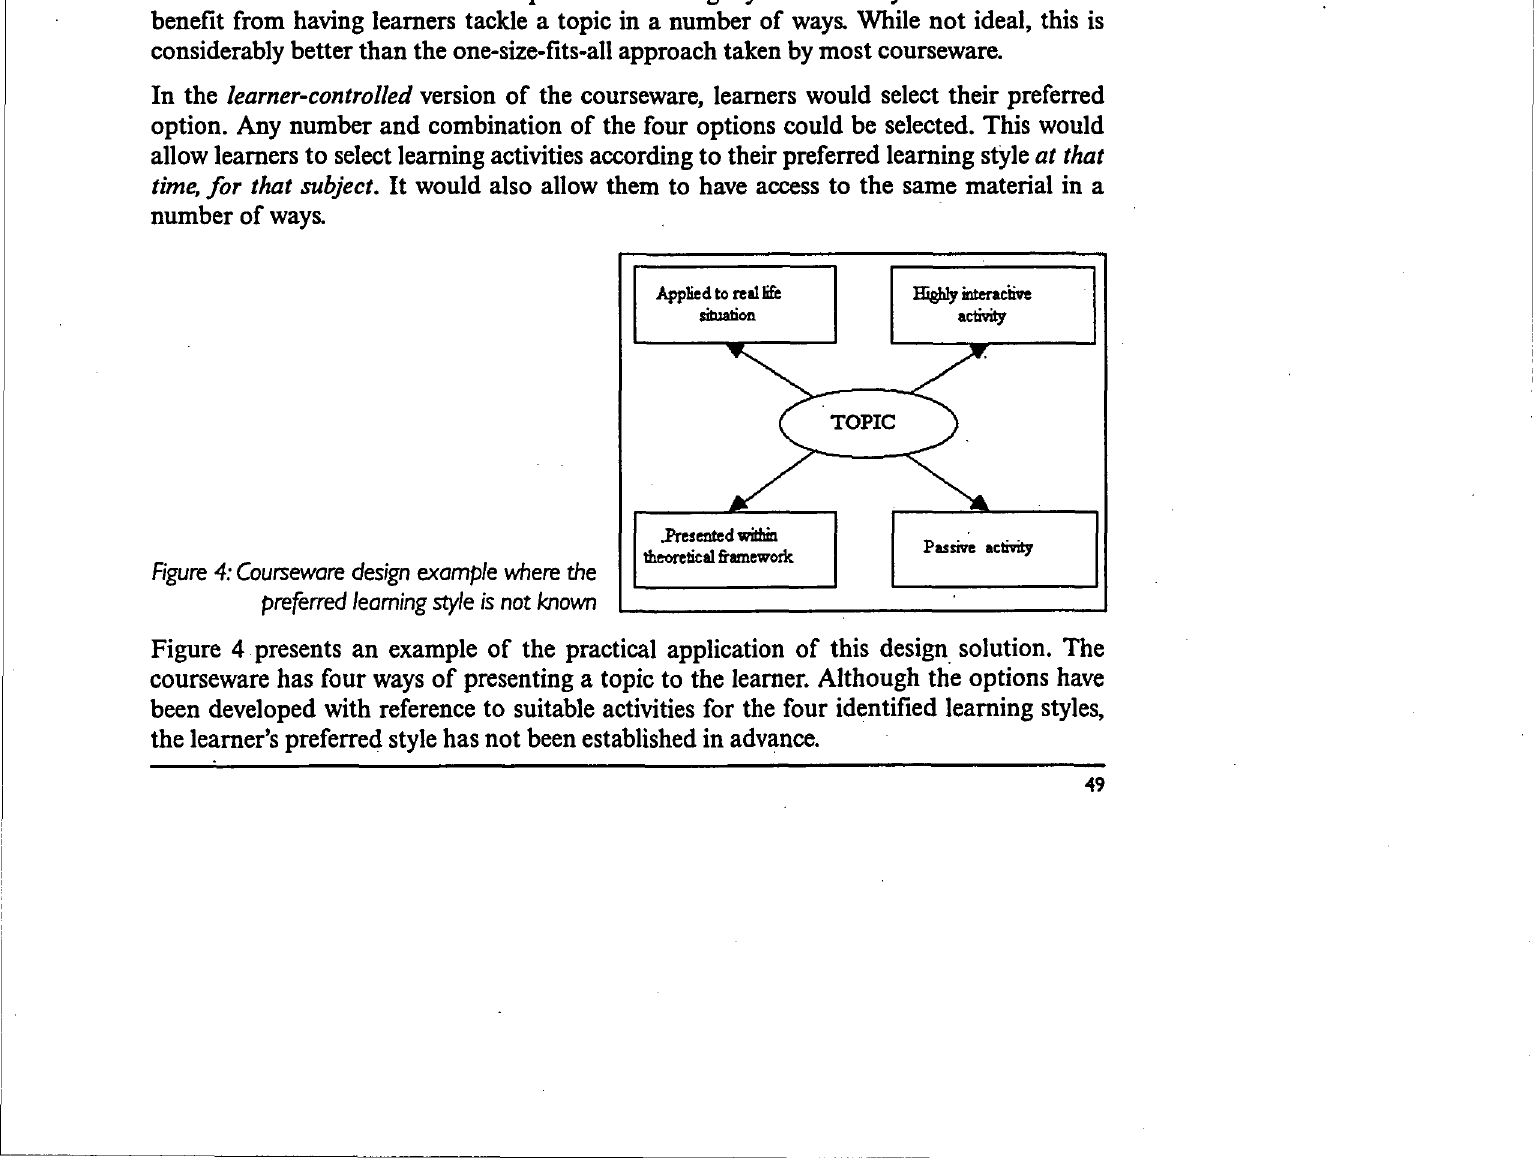
.Presented within theoretical